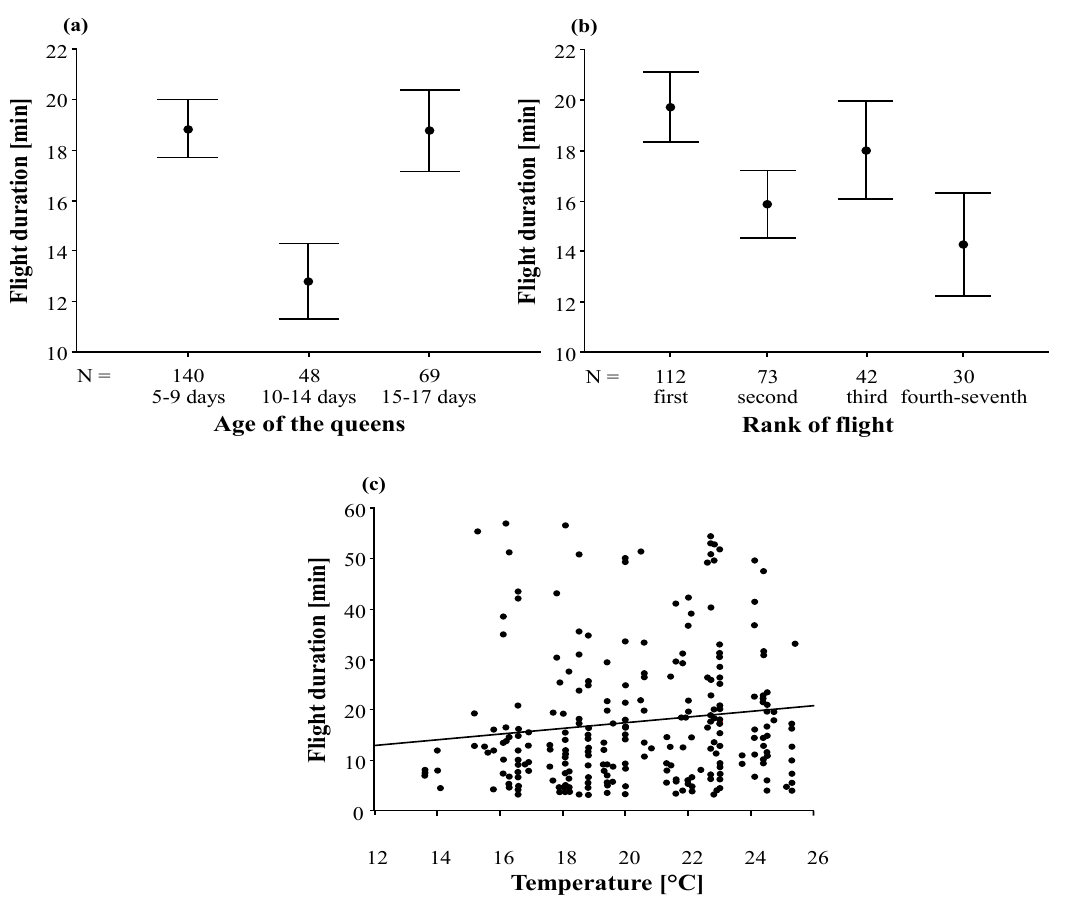
Figure 6. ( a ) Duration of the nuptial flights depending on the age of the queen. Arithmetic mean and standard error are given for each age class. N is the number of flights in the dataset. ( b ) Comparison of the duration of the first, second and third nuptial flights on a given day and all other flights of the same day. Arithmetic mean and standard error are given for each class. N is the number of flights in the dataset. ( c ) The nuptial flight duration in relation to the temperature when queens left their